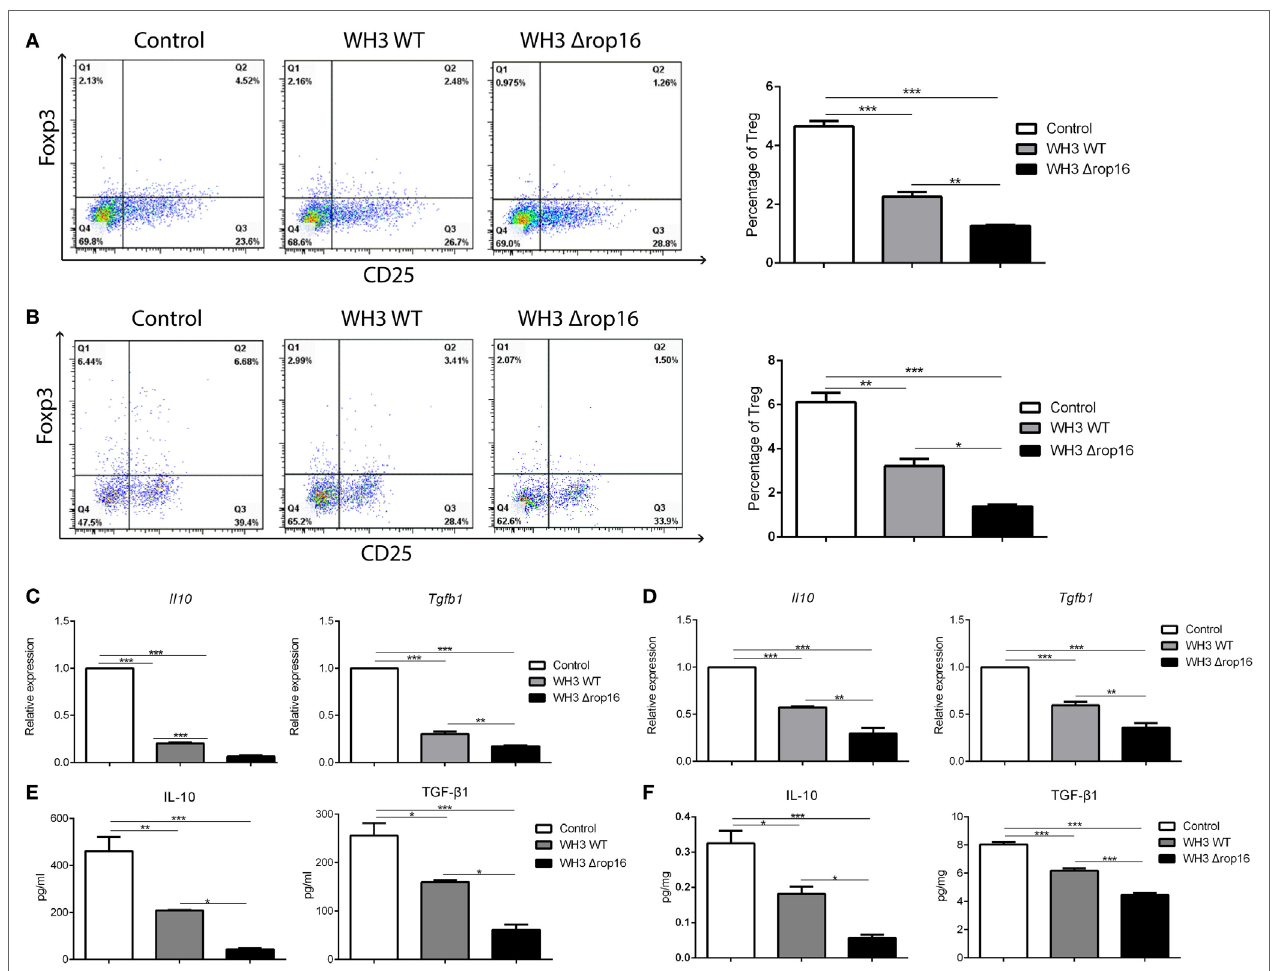
FigUre 6 | Toxoplasma WH3 Δ rop16 strain infection induced impairments of T regulatory cells (Tregs). Tregs cell population in the spleens (a) and placentas (B) were detected by flow cytometry. Tregs number was significantly decreased in WH3 Δ rop16 infected group compared to control group. The relative mRNA expressions interleukin (IL)-10 and transforming growth factor beta 1 (TGF- β 1) in the spleens (c) and placentas (D) were markedly reduced in WH3 Δ rop16 group. The levels of IL-10 and TGF- β 1 in the spleens (pg/ml) (e) and placentas (pg/mg) (F) were significantly decreased in the group of WH3 Δ rop16 (* p < 0.05, ** p < 0.01, *** p <